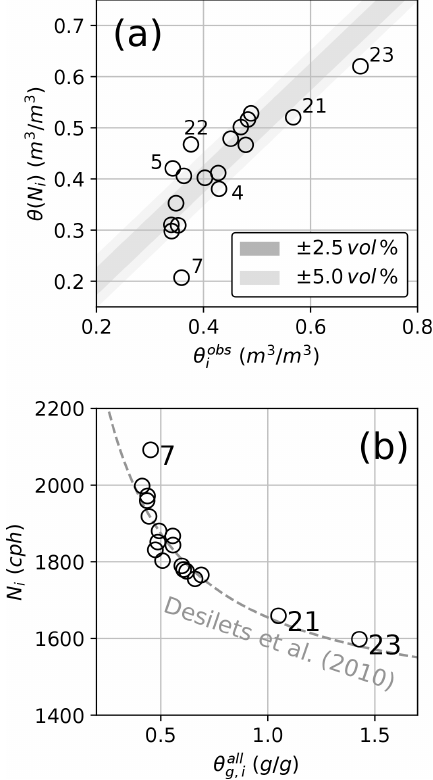
Figure 3. Results of the N 0 calibration: (a) shows the θ(N i ) ob- tained from standardized and corrected neutron count rates N i ver- sus the conventional soil moisture estimates θ obs , i.e. footprint- i averaged volumetric soil moisture obtained from manual sam- pling (25–26 June 2019). The grey shadows indicate deviations of 2.5% and 5% in θ(N i ). The bottom panel provides a different per- spective by plotting N i versus the observed total gravimetric soil water content, including water equivalents from soil organic mat- ter and lattice water; the dashed line indicates the Desilets function, Eq. (1), with a calibrated N 0 =